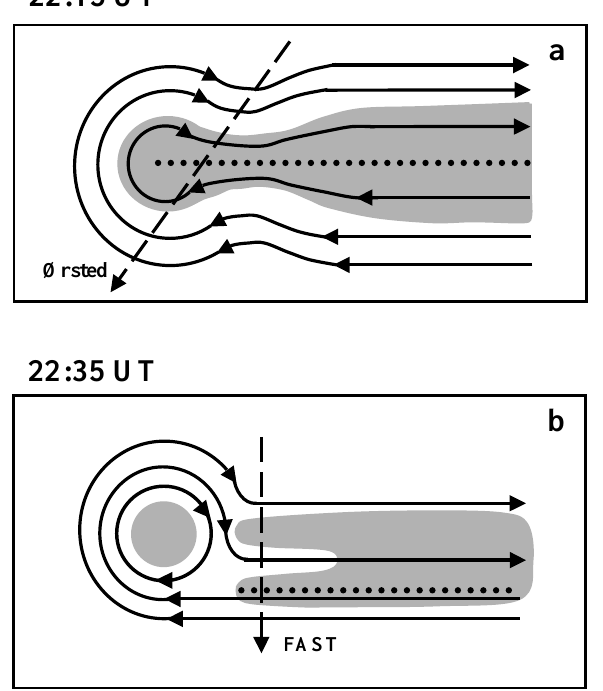
Fig. 12. Schematic representations of the ionospheric precipitation (grey surface) and convection pattern (solid lines) with the convec- tion velocity shear superimposed (dotted line). (a) At the time of the Ørsted pass with the Ørsted trajectory superimposed (dashed line). (b) At the time of the FAST pass, with the FAST trajectory superimposed (dashed